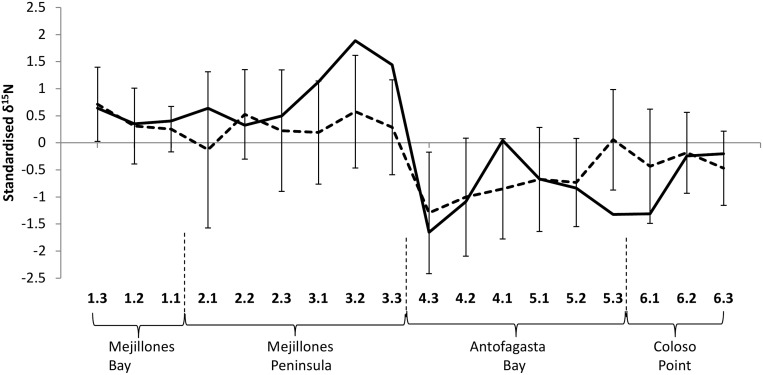
Geographical variation of standardised δ15N at sites along the coastline.The solid line shows size-corrected P. purpuratus δ15N, whilst the dashed line shows the mean (± SD) across standardised δ15N of all consumers (P. purpuratus, E. peruviana, S. viridula, T. atra) and putative resources (POM, epilithic biofilm, Ulva sp.). Site labels are presented below the graph in sequence around the coast, with the main geographical features summarised at the base of the graph (see Fig 1 for more detail).